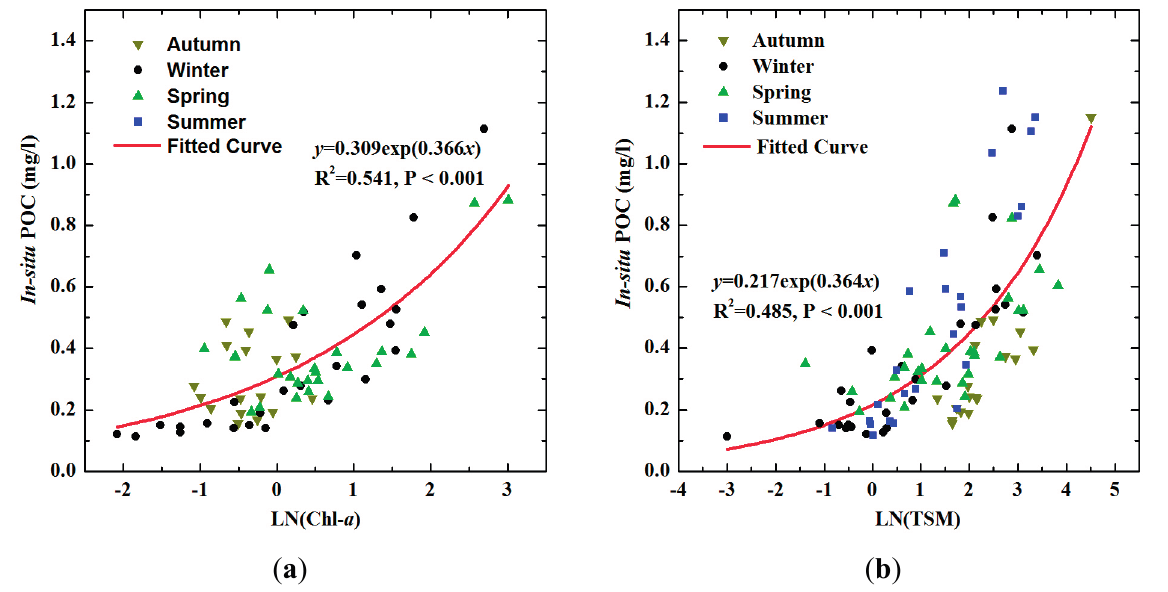
Figure 9. Relationship between POC concentration in the PRE and ocean color parameters: ( a ) Chl- a ; ( b ) TSM. Chl- a data are not available for the summer